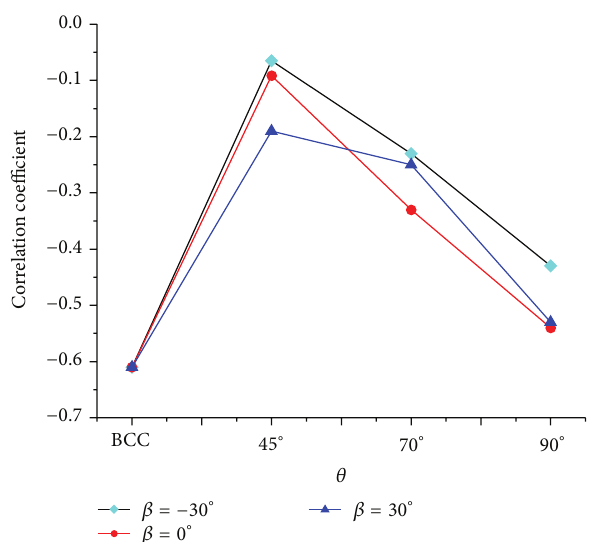
Figure 12: Correlation coefficients of the two peak points ( 𝑈𝑟 = 7